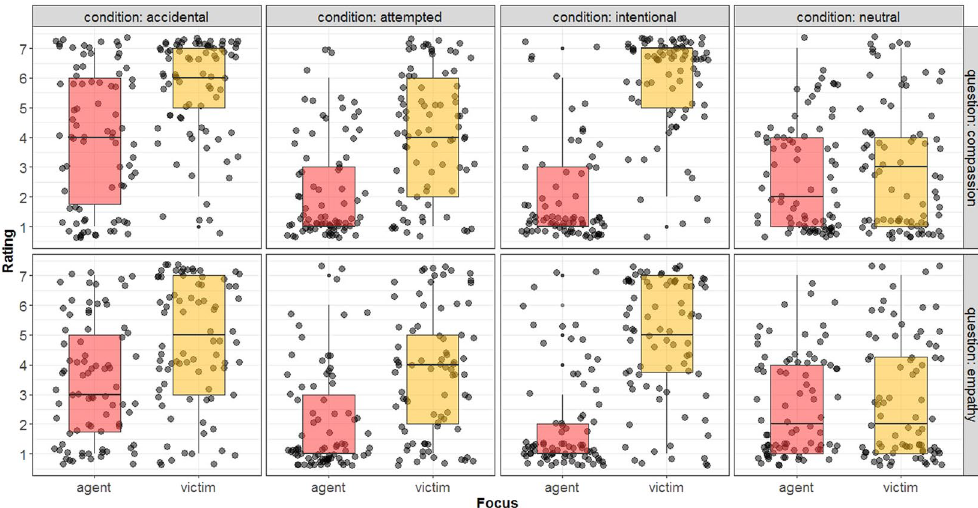
Figure 2. Empathy is for the victims of harm, not the agent. Boxplots with jittered data-points represent participants’ trial-by-trial ratings for empathy (affective sharing, i.e.) and compassion questions revealed that they empathized with and felt compassion for the victim, and not the agent, of the third-party dyad. Participants did report that they felt some empathy and compassion for agents involved in accidental harms.